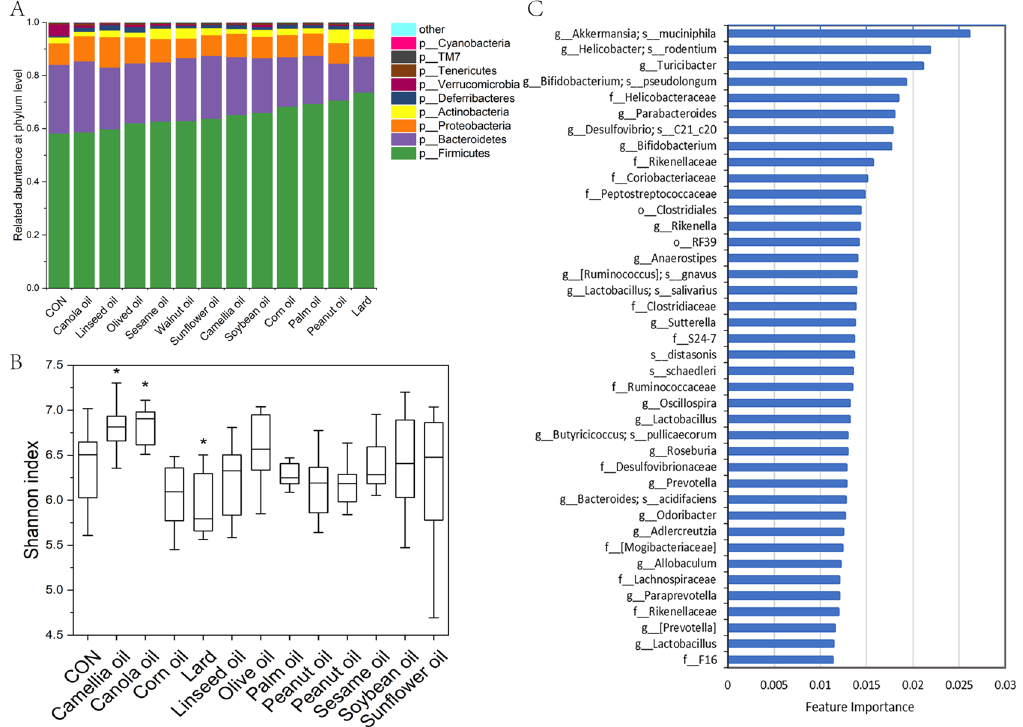
Figure 2. The effects of dietary fats on the gut microbiota. ( A ) The relative abundances of bacterial communities at the phylum level. The relative abundances of the top 9 abundant phyla were shown, while other less abundant phyla and unclassified reads were integrated into others. The treatment groups are sorted in ascending order by the content of Firmicutes. ( B ) The α-diversity indices of Shannon index in different intervention groups. The differences between any two groups were tested by Wilcox test. *p < 0.05. ( C ) Random forest analysis on faecal bacterial communities of all dietary oil intervention groups. The 40 most important predictors were ranked by the Gini index. The taxa are ranked from top to bottom by decreasing Gini index